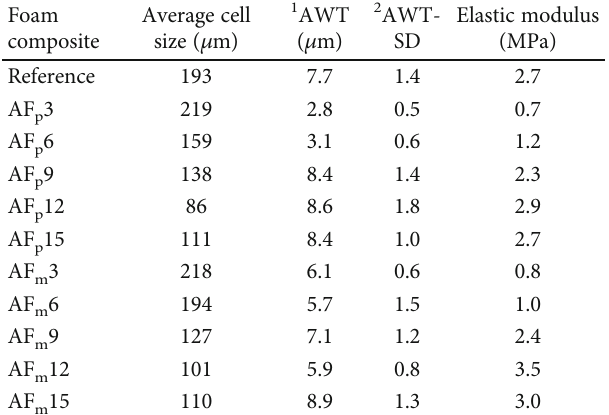
Table 1: Wall thickness and elastic modulus of the AF composites. Foam Average composite